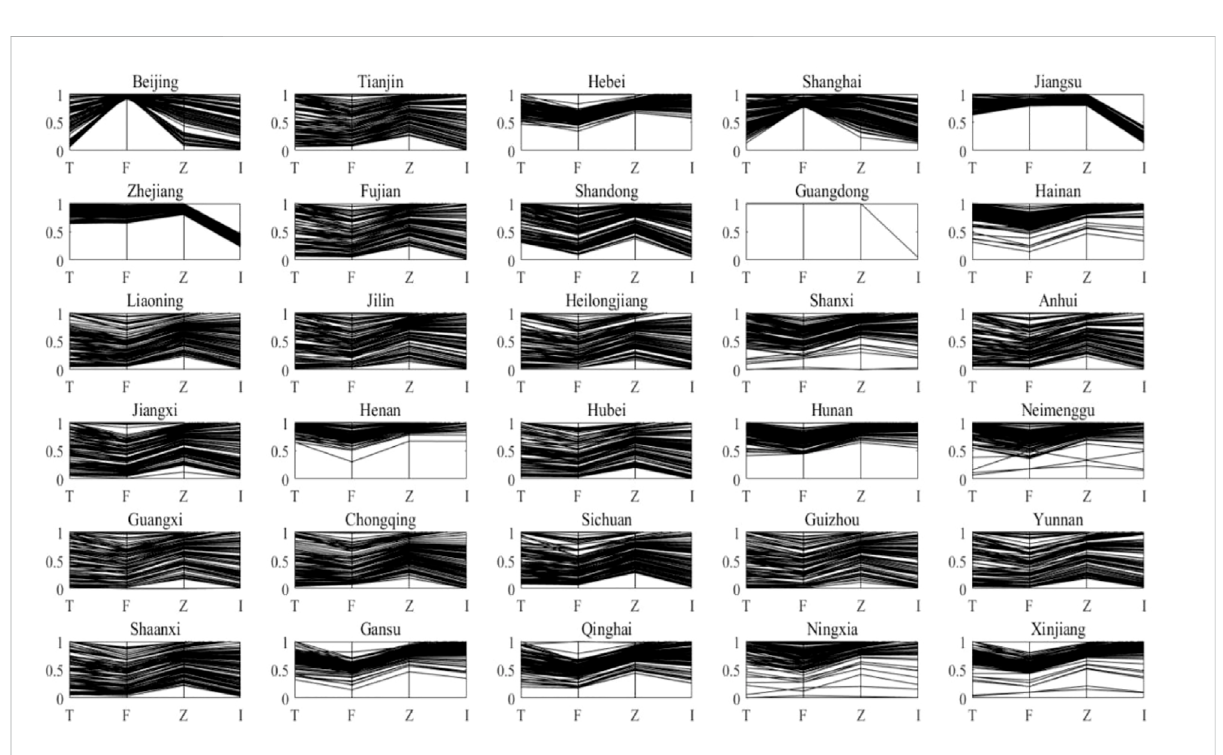
FIGURE 7 Optimization prediction for technology and fi nance. Note: F, Financial Support; T, Technology Innovation; Z, coupling coordinated Development; I,